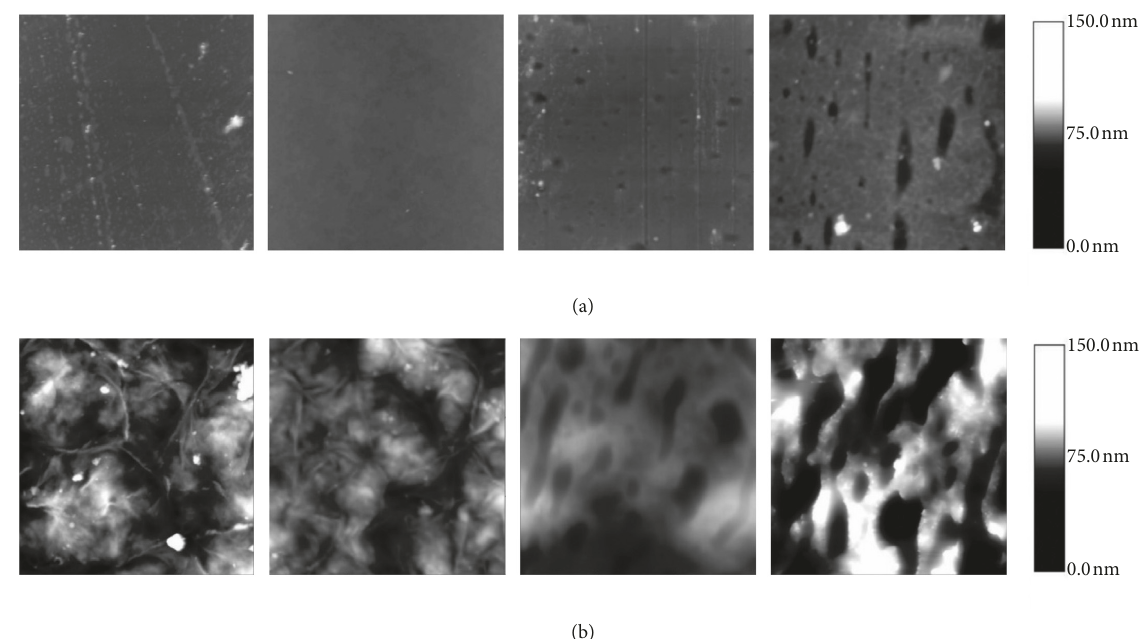
Figure 4: Selected 6 × 6 μ m AFM images of the surface erosion of PLA, 97PLA/3( R,S )-PHB, 91PLA/9( R,S )-PHB, and 85PLA/15( R,S )-PHB blend samples, respectively, before (a) and after (b) 52weeks of the degradation process in paraffin (adapted with permission from ref.